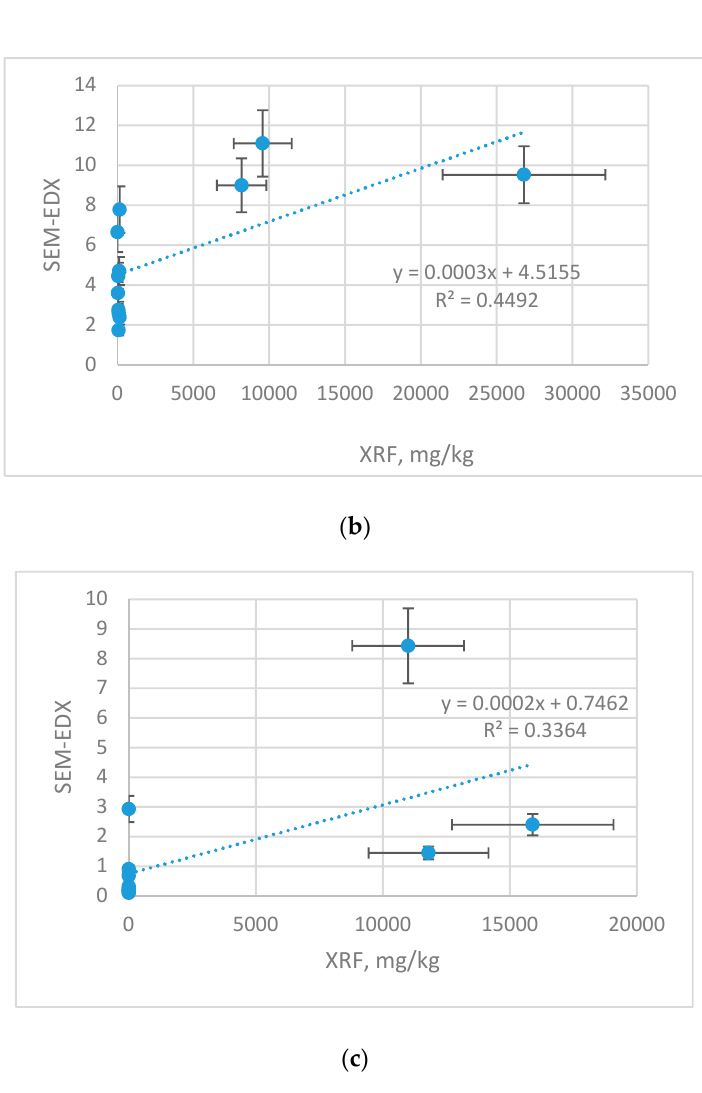
Figure 4. Correlation between XRF and SEM-EDX results [26] : ( a ) Cu; ( b ) Zn; ( c ) Mn.